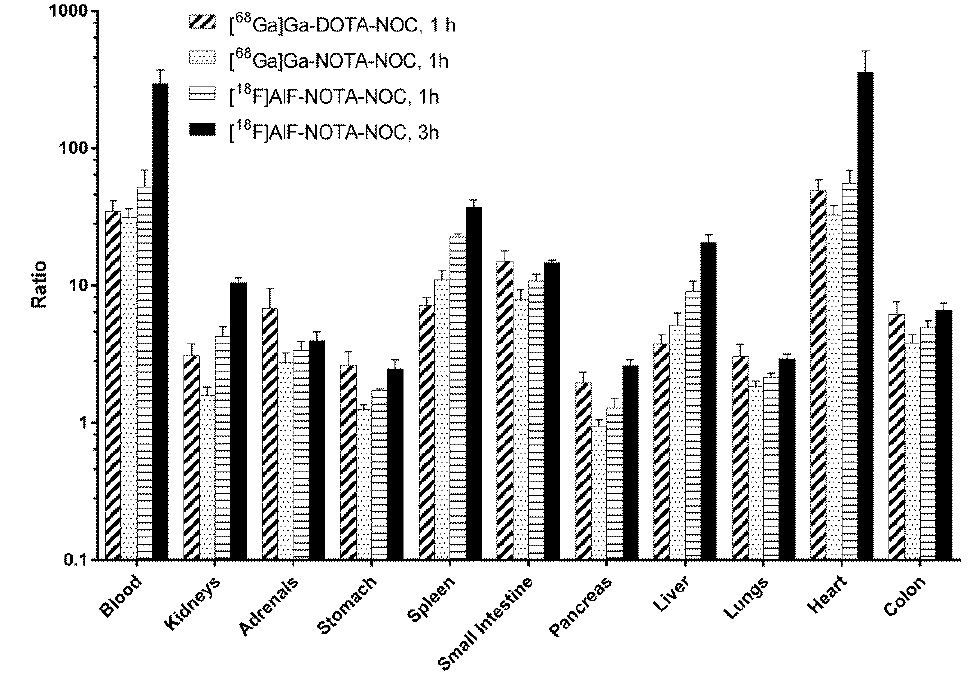
Figure 2. Tumor-to-organ ratios for each organ and radiopharmaceutical.